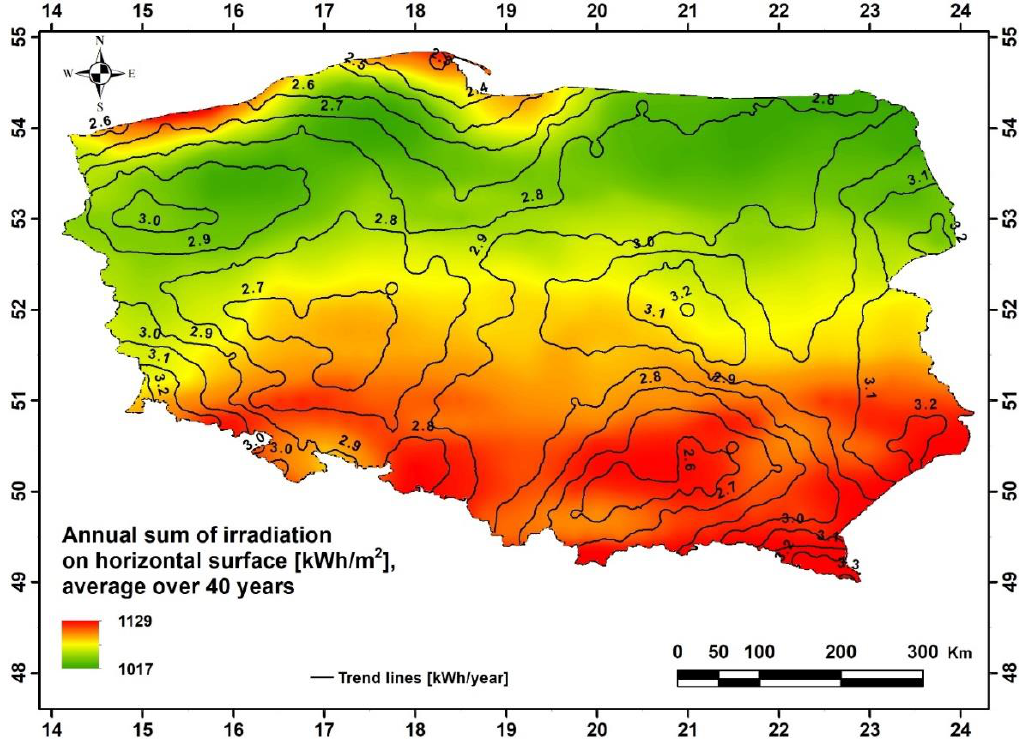
Figure 3. Spatial distribution of solar resources in Poland. Data represents mean resource availability on horizontal surface calculated from hourly time series for 1980 – 2019. Contour lines represent linear trends.